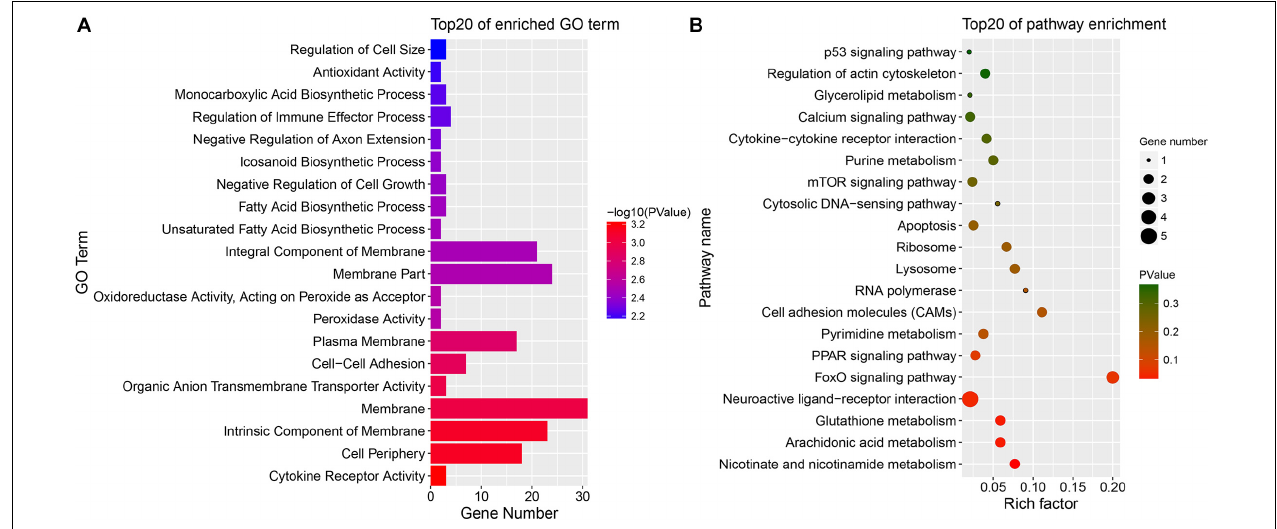
FIGURE 7 | Enrichment DE mRNAs in different comparison group. (A) GO enrichment for DE mRNA; (B) KEGG enrichment for DE mRNA. SYF, small yellow follicle; F6, the smallest hierarchical follicle; F1, the largest hierarchical